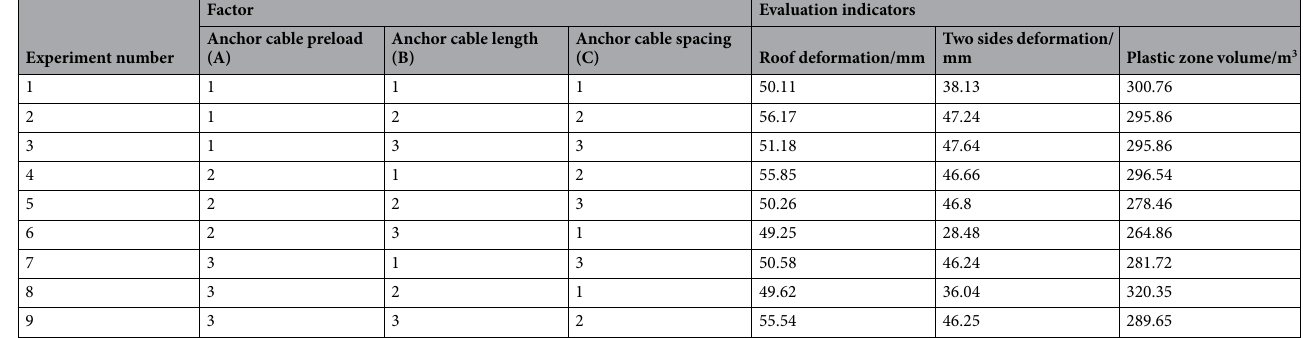
Table 4. Orthogonal experimental